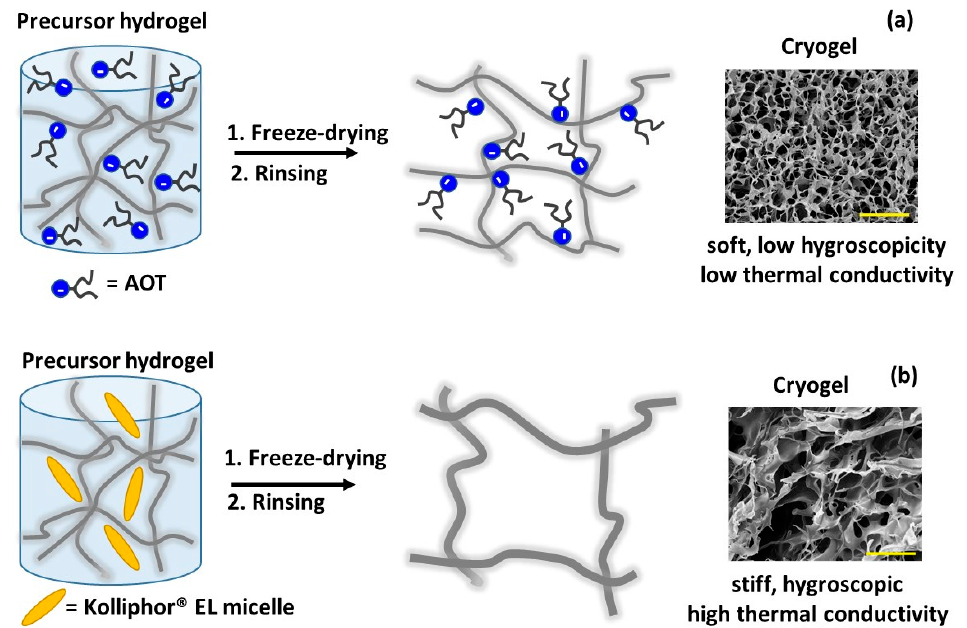
Figure 8. Schematic representation of the model proposed to explain the effects of adding ( a ) AOT or ( b ) Kolliphor ® EL to the precursor hydrogel on the microstructure and the properties of the resulting cryogels. After rinsing to remove the molecules that did not react, the cryogels were freeze-dried again and were characterized. Due to the strong interactions between the AOT and HPMC, the AOT molecules remained adsorbed on the HPMC cell walls, rendering softness and less hygroscopic cryogels. The Kolliphor ® EL molecules promoted the formation of larger ice crystals and consequently larger pores and thicker cell walls.